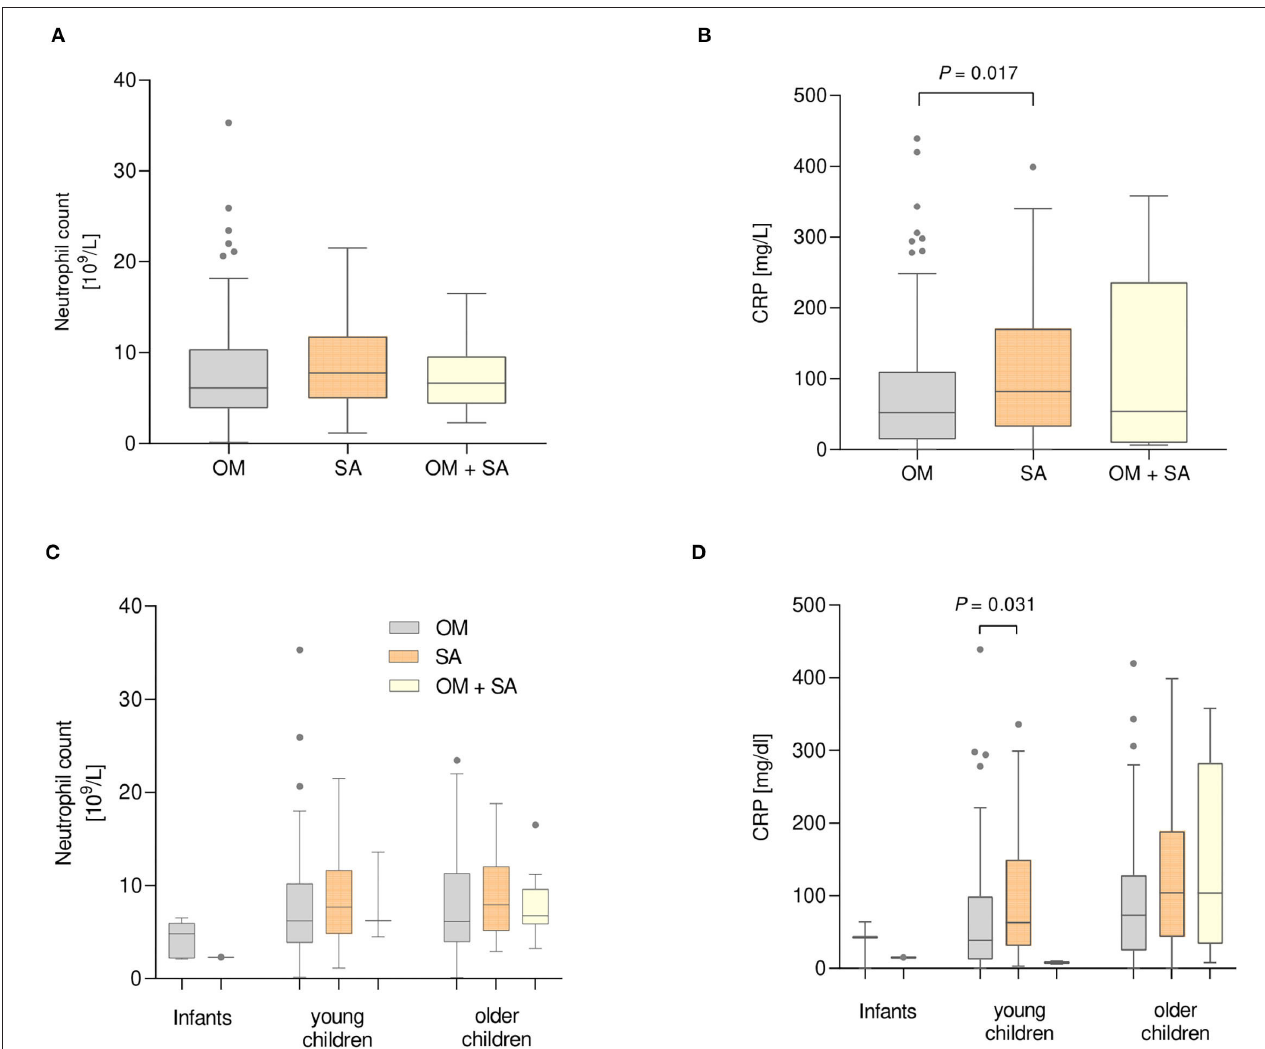
FIGURE 5 | Neutrophil count (A) and C-reactive Protein (CRP) levels (B) measured in serum of patients with Bone and Joint infections. (A) n = 118 OM, 86 SA and 14 OM + SA patients. (B) n = 134 OM, 101 SA and 14 OM + SA patients. Neutrophil count (C) and CRP levels (D) of patients divided into three age groups. (C) n = 5 infants, 44 young and 69 older children with OM; 56 young and 30 older children with SA; 1 infant, 3 young and 10 older children with OM + SA. (D) n = 3 infants, 48 young and 83 older children with OM; 61 young and 40 older children with SA; and 1 infant, 3 young and 10 older children in the OM + SA group. Kruskal-Wallis test with Dunn’s